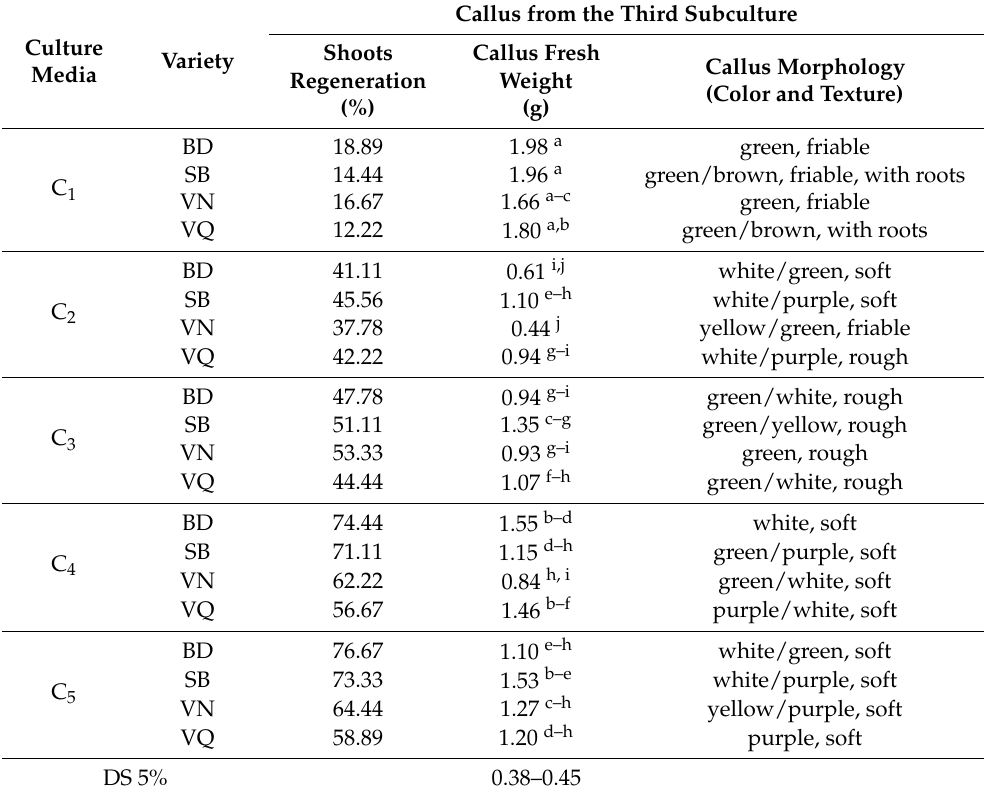
Table 10. Morphological aspects of calli obtained from the third subculture.